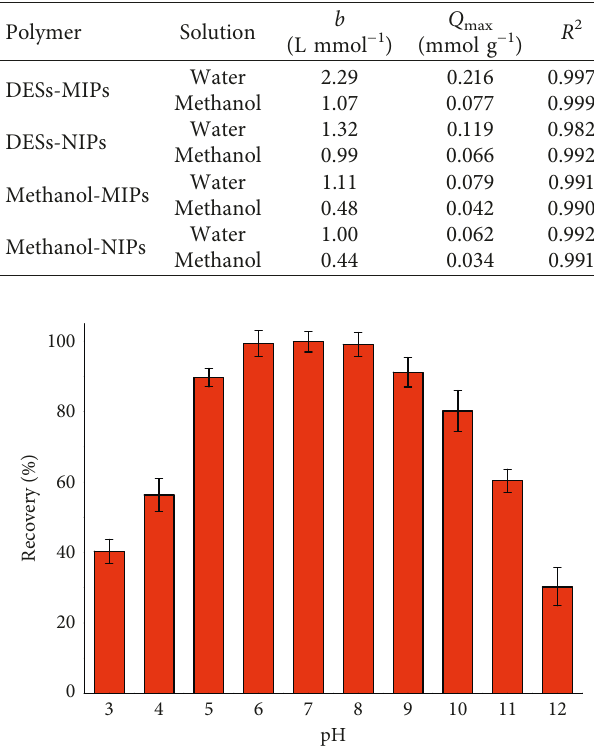
Figure 5: Effect of pH on the recovery of